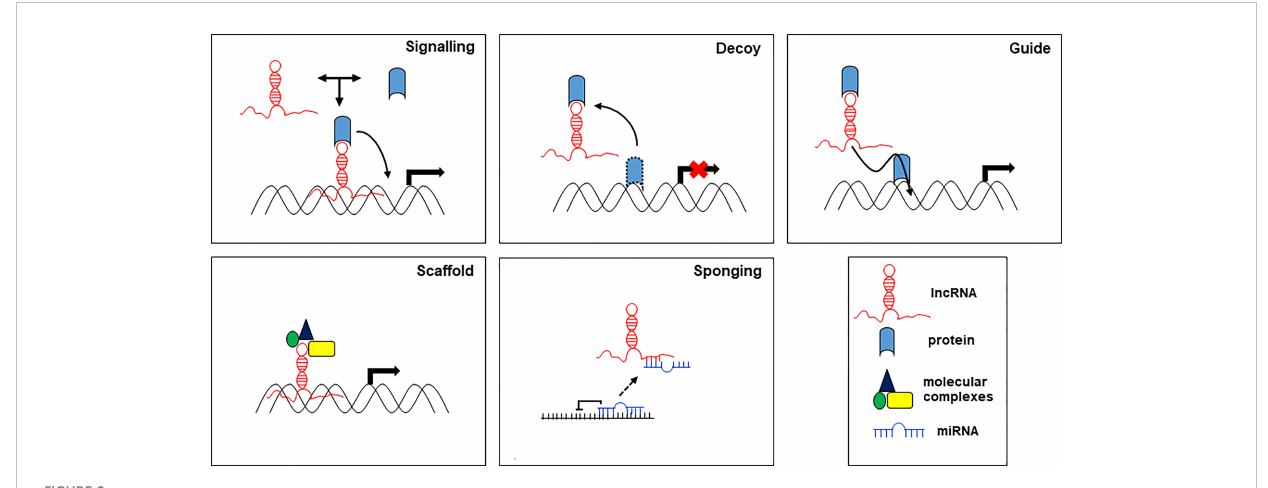
FIGURE 2 Main proposed working mechanisms for lncRNA based on their